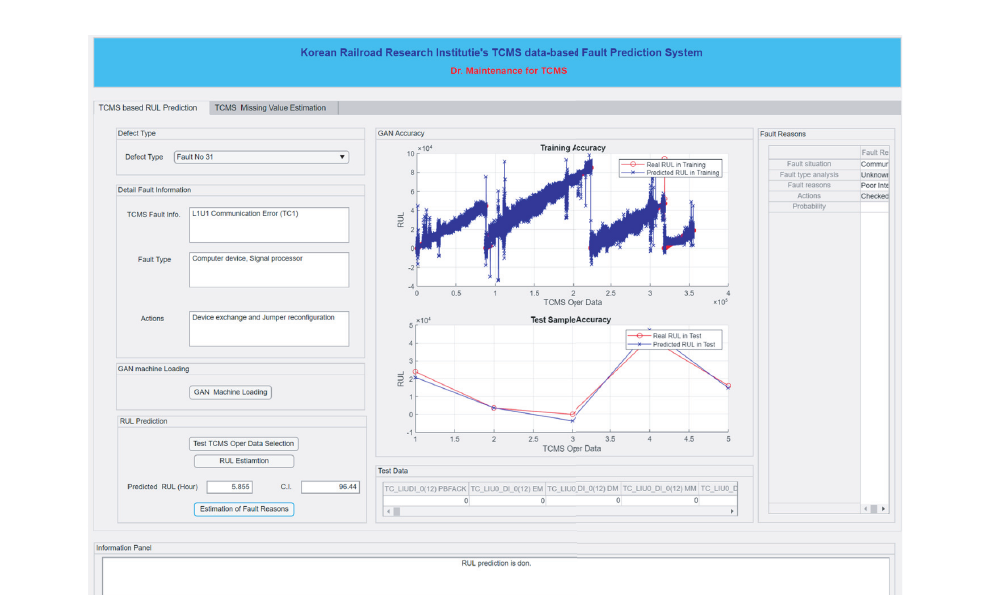
Figure 8: The implementation of GAN-based missing value handling and RUL prediction